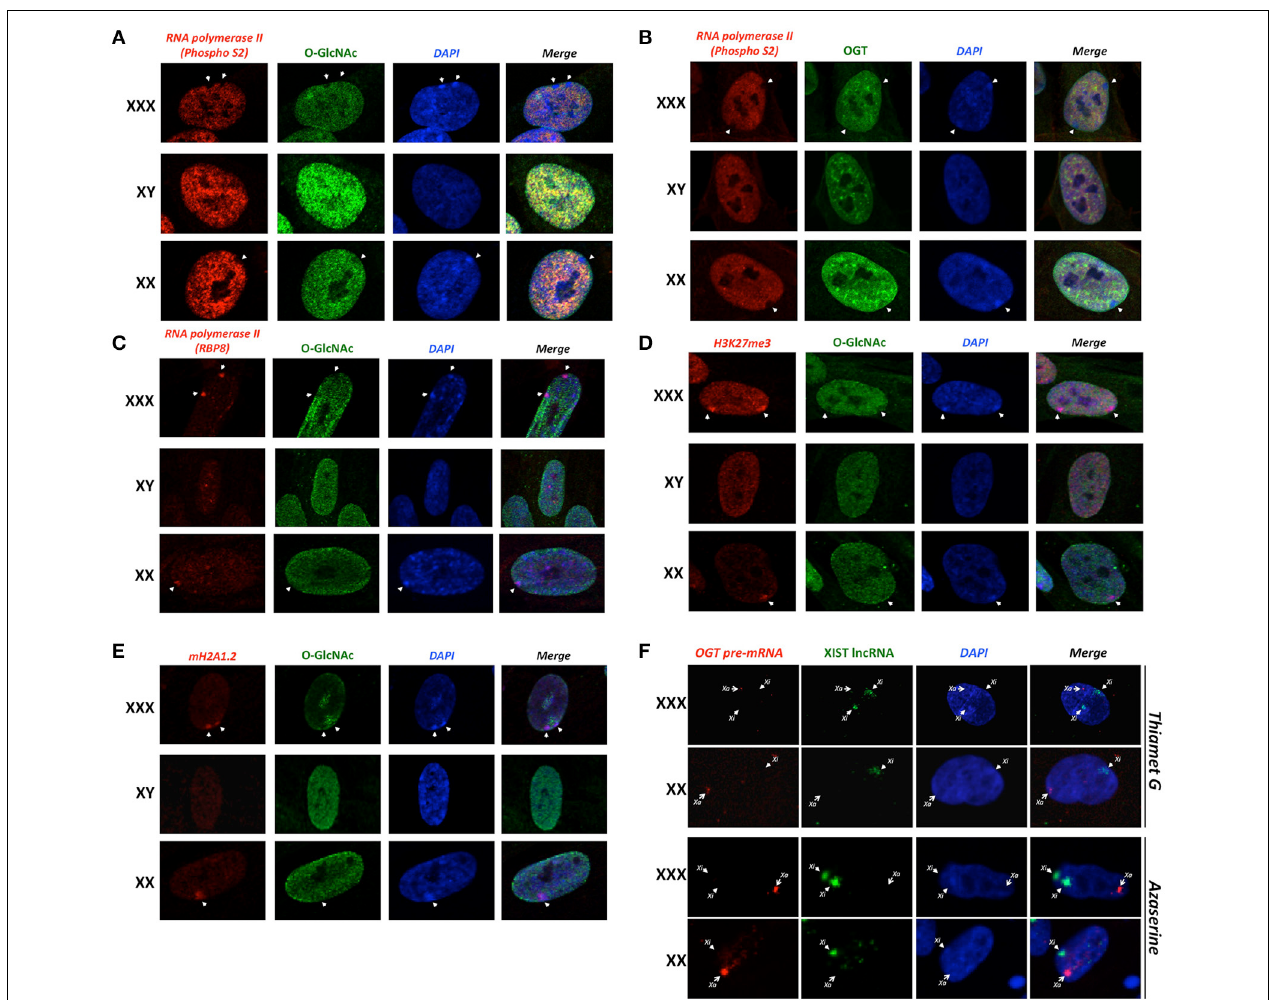
FIGURE 3 | Barr bodies do not require O -GlcNAc cycling. (A) A strong-DAPI staining signal and/or a lack of elongating RNA polymerase II (PhosphoS2) signal were used to localize Barr bodies (white arrows). O -GlcNAc staining is largely excluded from Barr body. (B) OGT is also less intense in Barr body. (C) Unlike elongating RNA polymerase II (PhosphoS2), unmodified RNA polymerase II co-localized with the Barr body. (D) Barr bodies were identified as in this figure. H3K27me3 strongly co-localized with